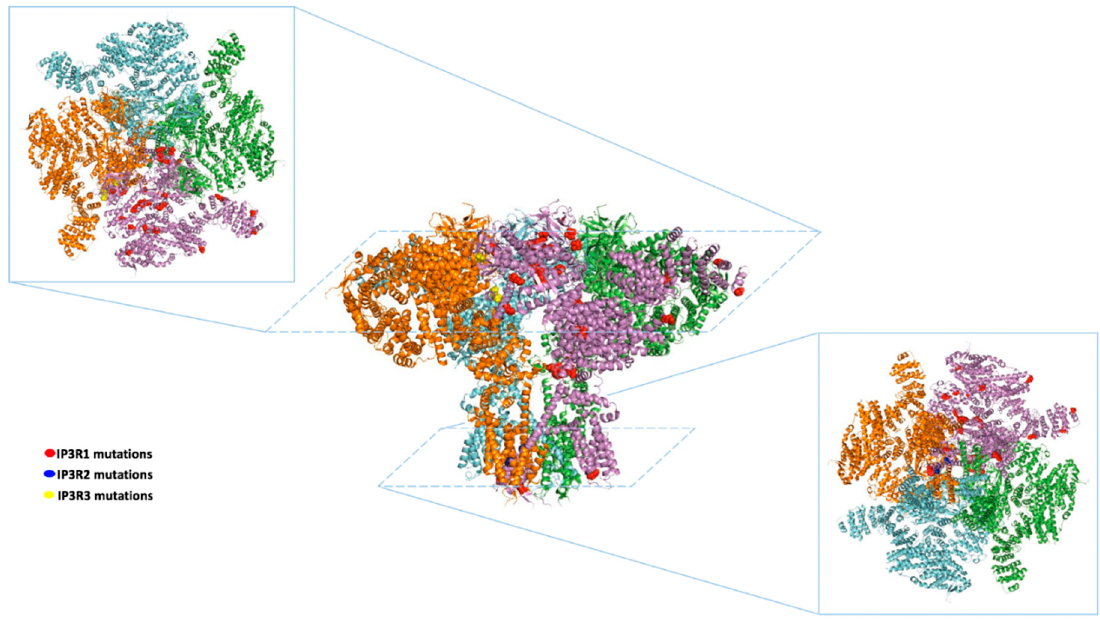
Figure 1. Representative structure of inositol 1,4,5-trisphosphate receptors (ITPRs) (1-3) showing disease-related mutations. In the middle, representative “mushroom-like structure” of ITPRs. For clarity, only the crystal of human isoform 3 is shown. Top left corner: View from the top; bottom right corner: View from the bottom. The residues in red, blue, and yellow indicate the mutations in ITPR1, 2, and 3, respectively, that have been hitherto reported in humans.